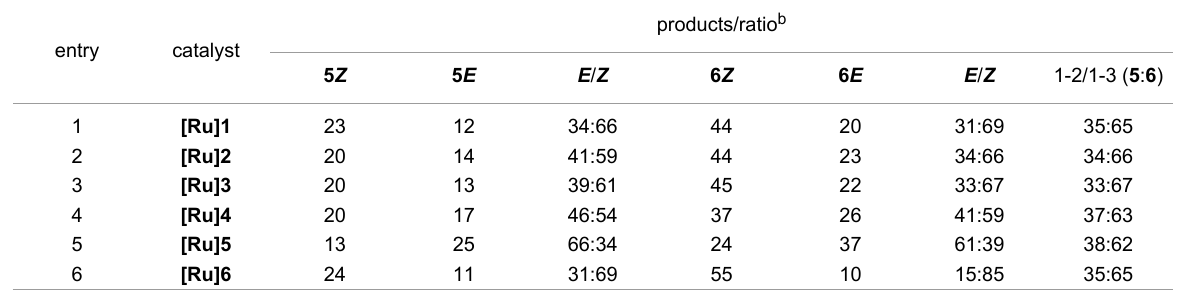
Table 2: Influence of the catalyst on ROCM product distribution (reaction of 1 with 3 ) a .